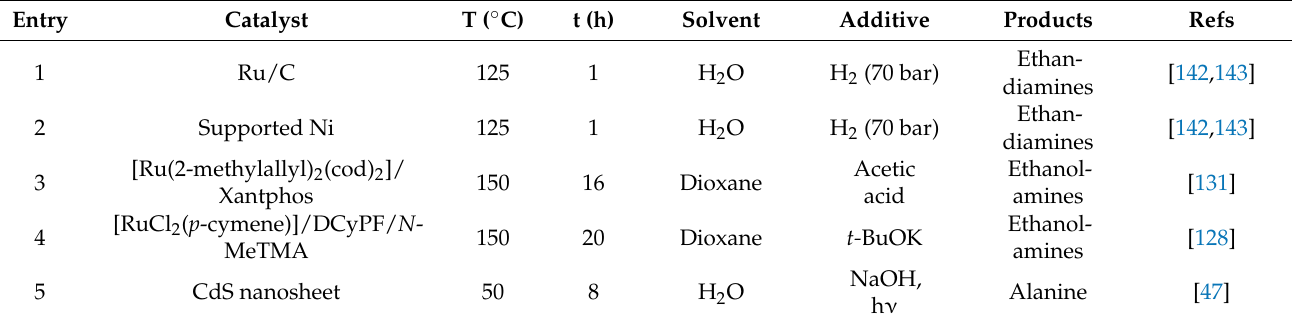
Scheme 52. C2-diamine formation from glucose amination over Ru/C. Table 8. Catalytic amination of unprotected carbohydrates.